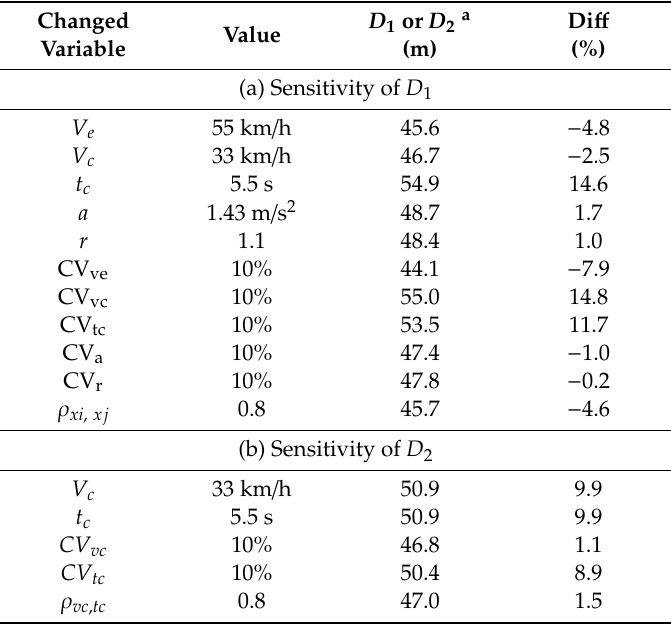
Table 8. Sensitivity of D 1 and D 2 to various input